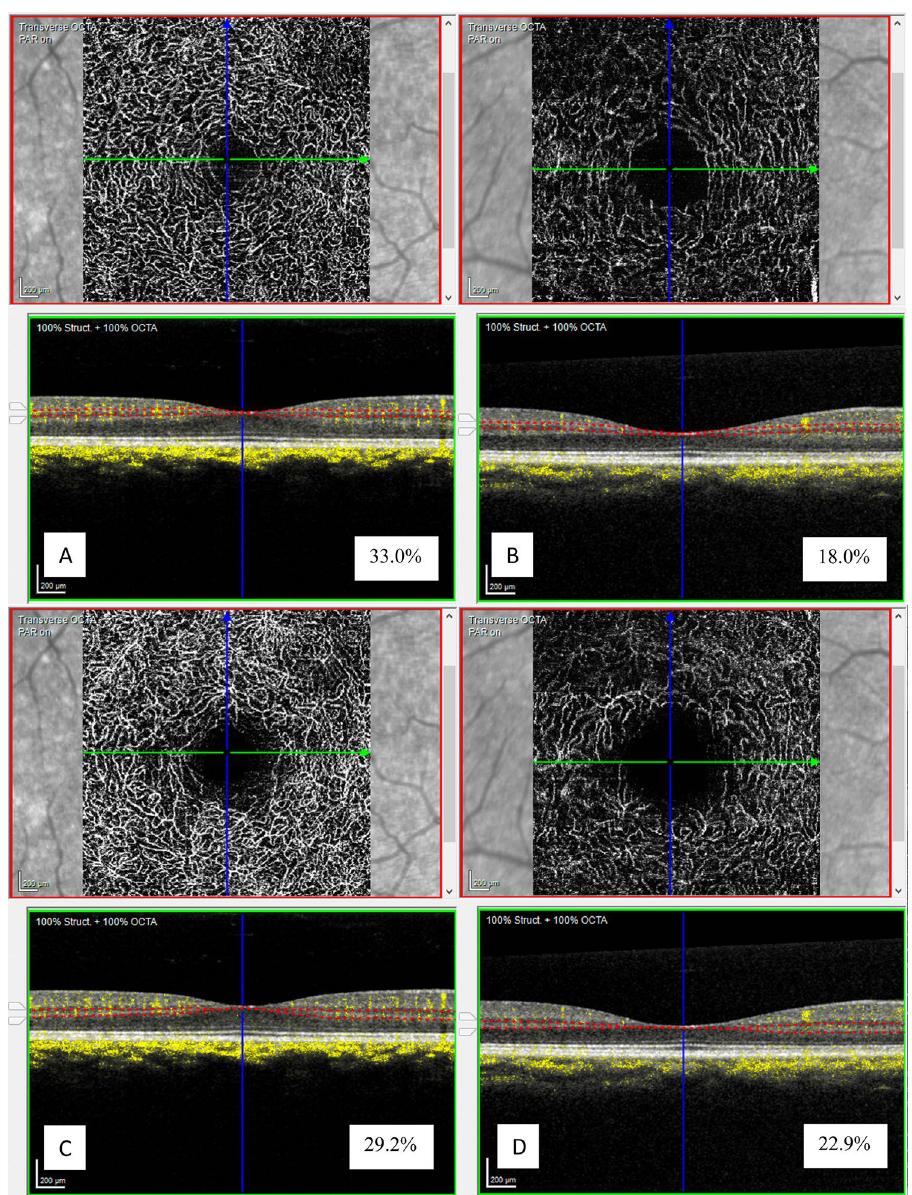
Figure 4. Representative OCTA images of the ICP ( A,B ) and DCP ( C,D ) slabs of normal participant ( A,C ) and severe COVID-19 participant ( B,D ) with their corresponding vessel densities (in percentage). OCTA optical coherence tomography angiography, ICP intermediate capillary plexus, DCP deep capillary plexus, COVID-19 coronavirus